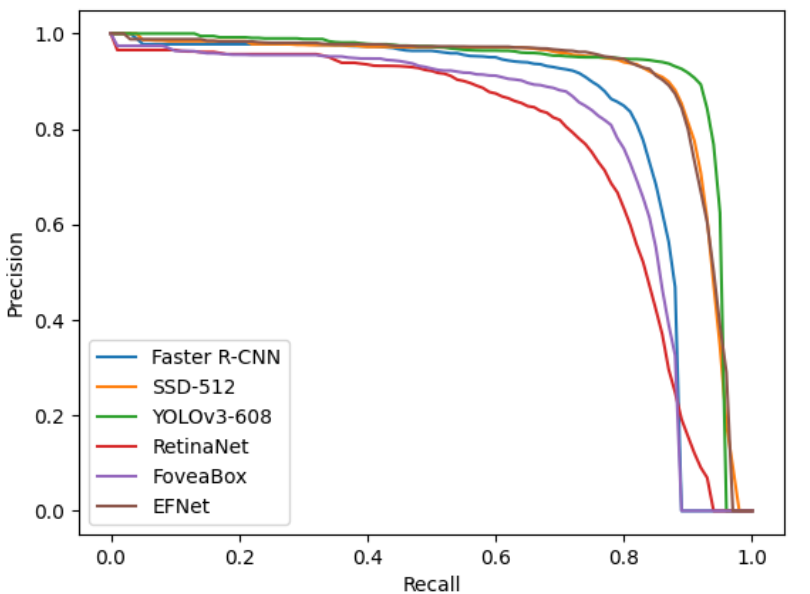
Figure 11. The PR curves of category bridge for comparative methods on HRRSD. These curves are the different IoU s between predicted boxes and